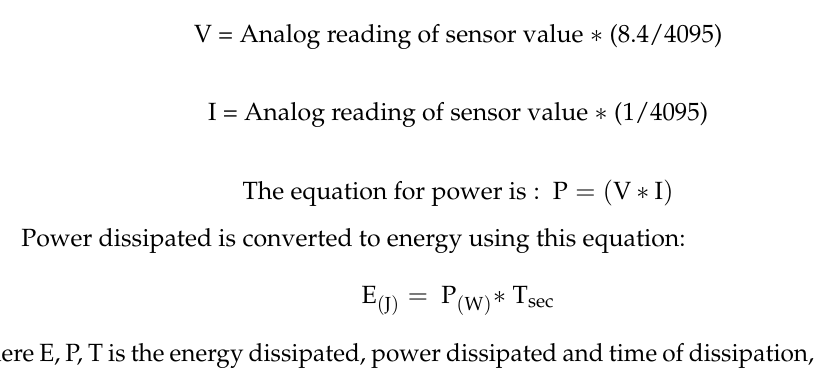
Figure 10. Mobile anchor node with MAX471 Voltage and Current Sensor Module Consume Voltage Load Detection